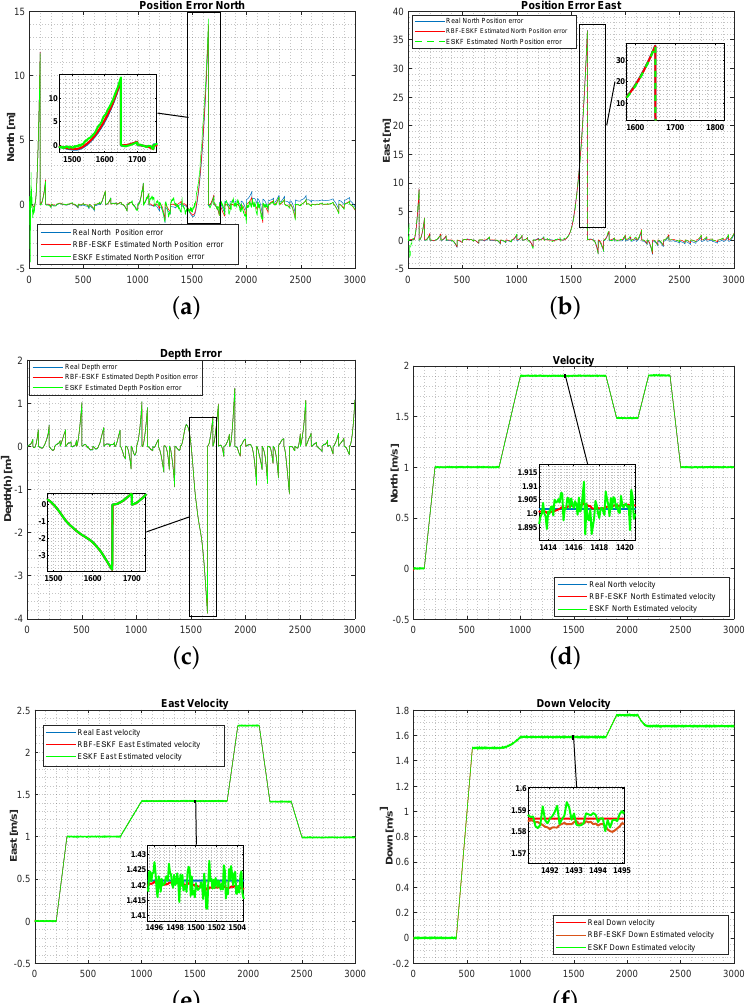
Figure 6. Simulation results of ESKF and RBF-ESKF for time 0–3000 s (x-axis) in case 2. ( a – c ) The position error significantly grows with a loss of acoustic fix. The proposed algorithm estimation is close to the actual error. ( d – f ) RBF-EKF has a minimal effect of acoustic fix loss on velocity estimation, and the response is much smoother than that of